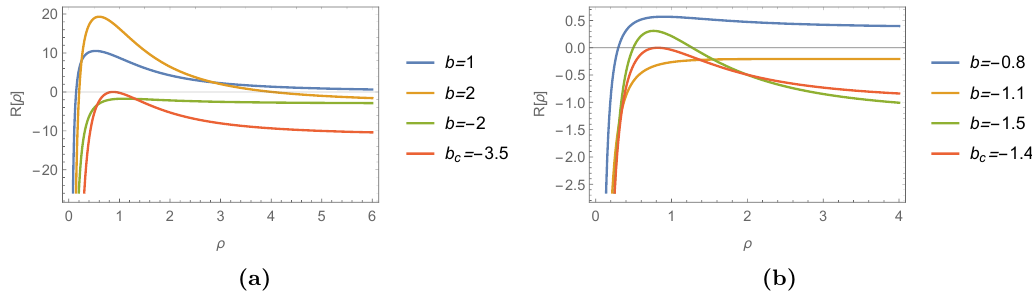
Figure 9. Radial function R ( (cid:26) ) as a function of b and (cid:26) for a) (cid:23) = 4 and b) (cid:23) = 10. For (cid:23) < (cid:23) no critical geodesics exists. We (cid:12)nd that geodesics fall into two di(cid:11)erent cat- min egories: scattered geodesics impinging from in(cid:12)nity and (cid:12)nding at most one turning point (green region), and stable orbits con(cid:12)ned in the interior of AdS (grey regions) bouncing between two turning points. This behavior is shown in (cid:12)gure 9, where we draw the radial function R ( (cid:26) ) for di(cid:11)erent values of the impact parameter b . As an example for b = 1 ((cid:12)gure (a)) or b = (cid:0) 0 : 8 ((cid:12)gure (b)) the particle comes from in(cid:12)nity and reaches a turning point (cid:26) when R ( (cid:26) ) = 0. For b = 2 ((cid:12)gure (a)) or b = (cid:0) 1 : 5 ((cid:12)gure (b)) the particle T T bounces back and forth between two turning